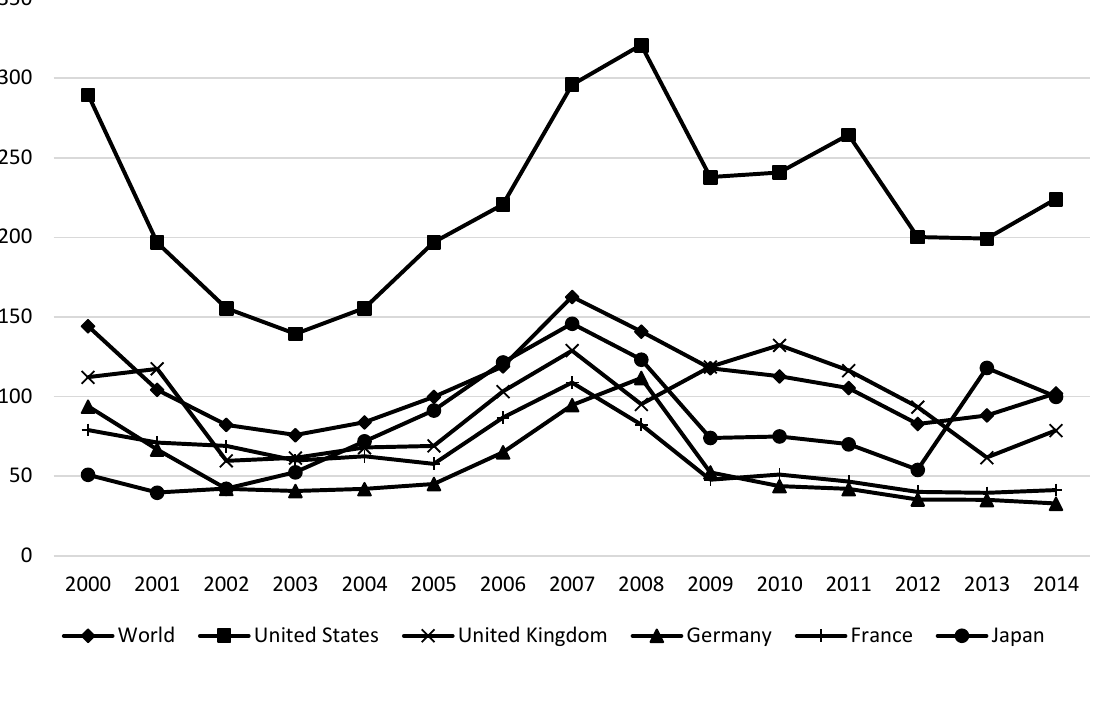
Figure 1. Dynamic of stock traded, total value, % of